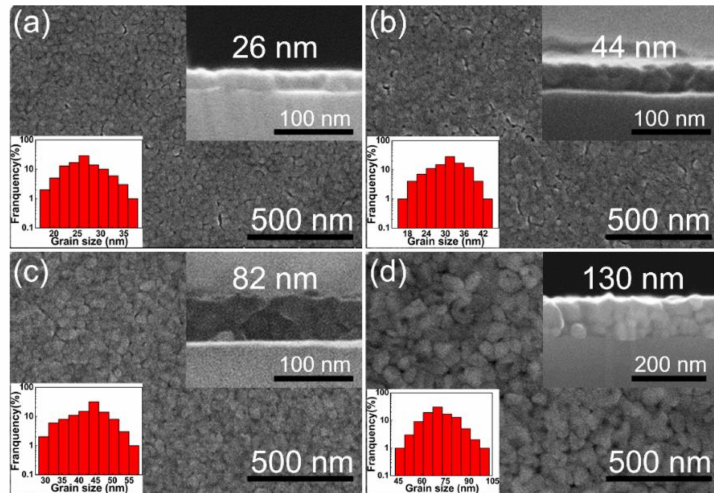
Figure 3. FE-SEM results of the CrN thin films with di ff erent thicknesses: ( a ) 26, ( b ) 44, ( c ) 82 and ( d ) 130 nm. The thicknesses and the histograms of the grain size are shown in the corresponding insets.